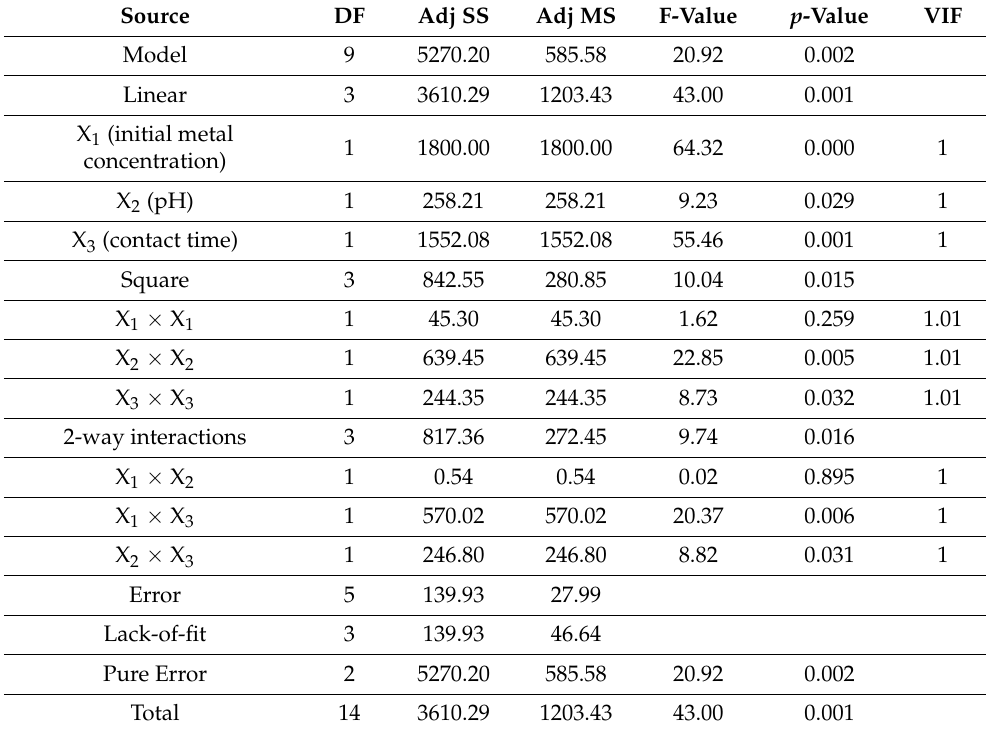
Table 4. ANOVA table for cadmium removal with